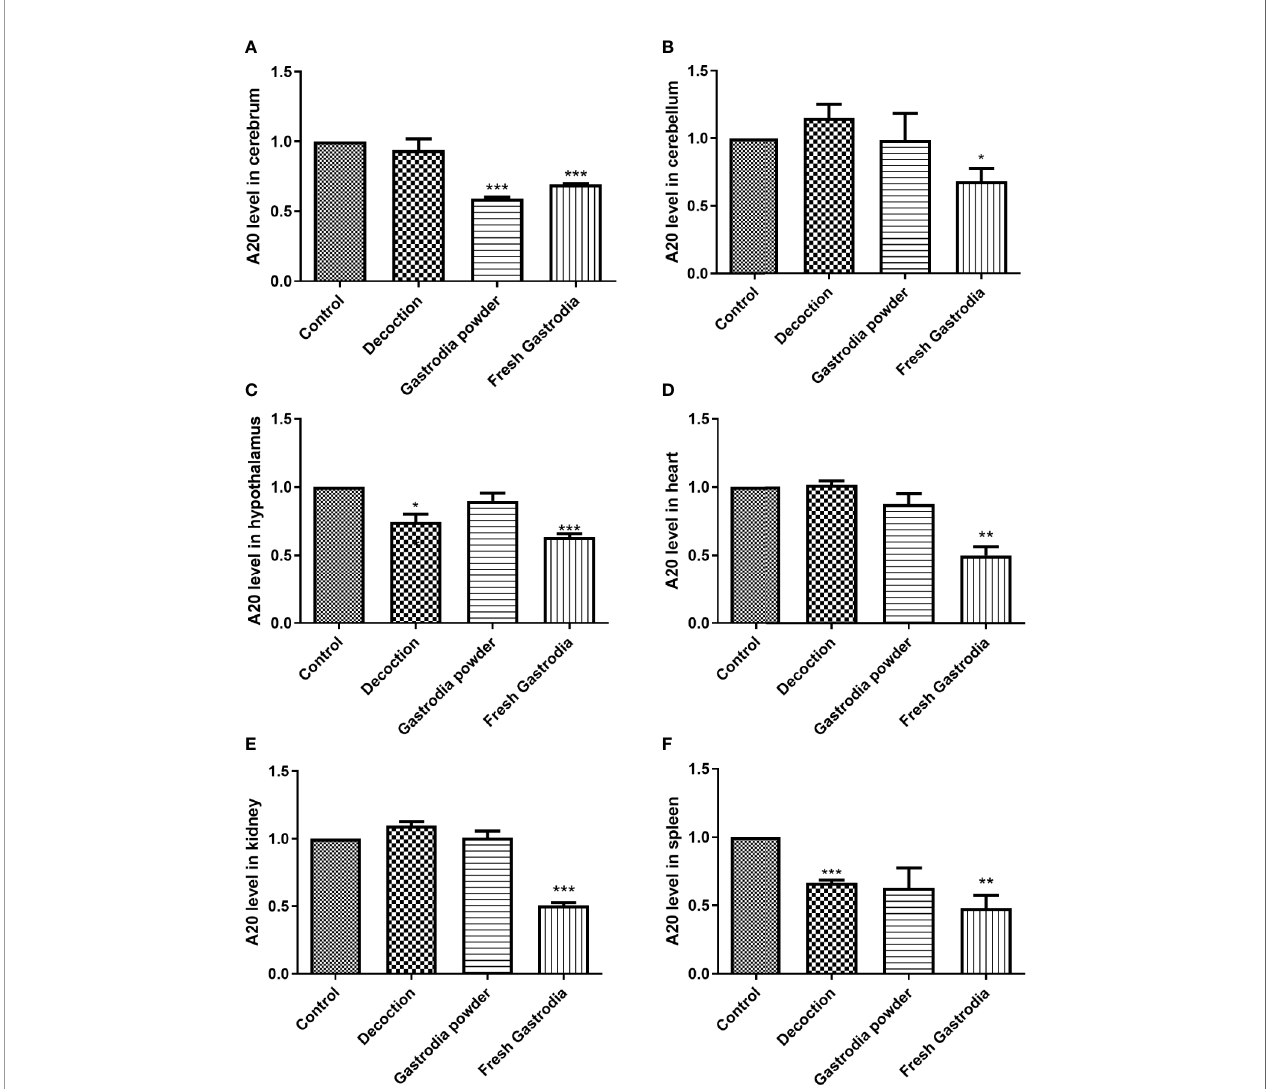
FIGURE 7 | The A20 expression was downregulated in many tissues of mouse. The result of qRT-PCR showed the mRNA level of A20 in various tissues of mice. (A) Cerebrum. (B) Cerebellum. (C) Hypothalamus. (D) Heart. (E) Kidney. (F) Spleen. * p < 0.05; ** p < 0.01; *** p < 0.001 compared with the control group, n = 6. Values are the mean ±